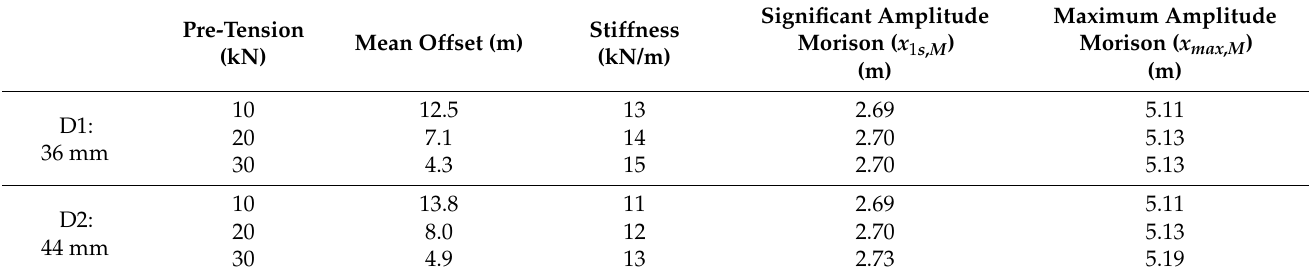
Table 9. Case 1, wave results from Morison